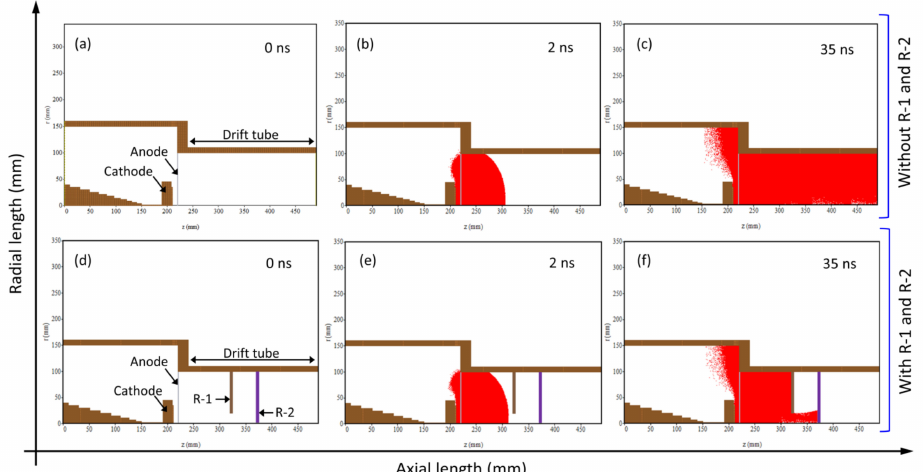
Figure 3. The behavior of IREB particles in real schematic space. ( a ) A traditional axial VCO structure devoid of reflectors, ( b , c ) shows the device after IREB emission at 2 and 35 ns simulation times, respectively. ( d ) The device structure with two reflectors, and ( e , f ) show the IREB behavior in the modified VCO structure at 2 ns and 35 ns simulation times.